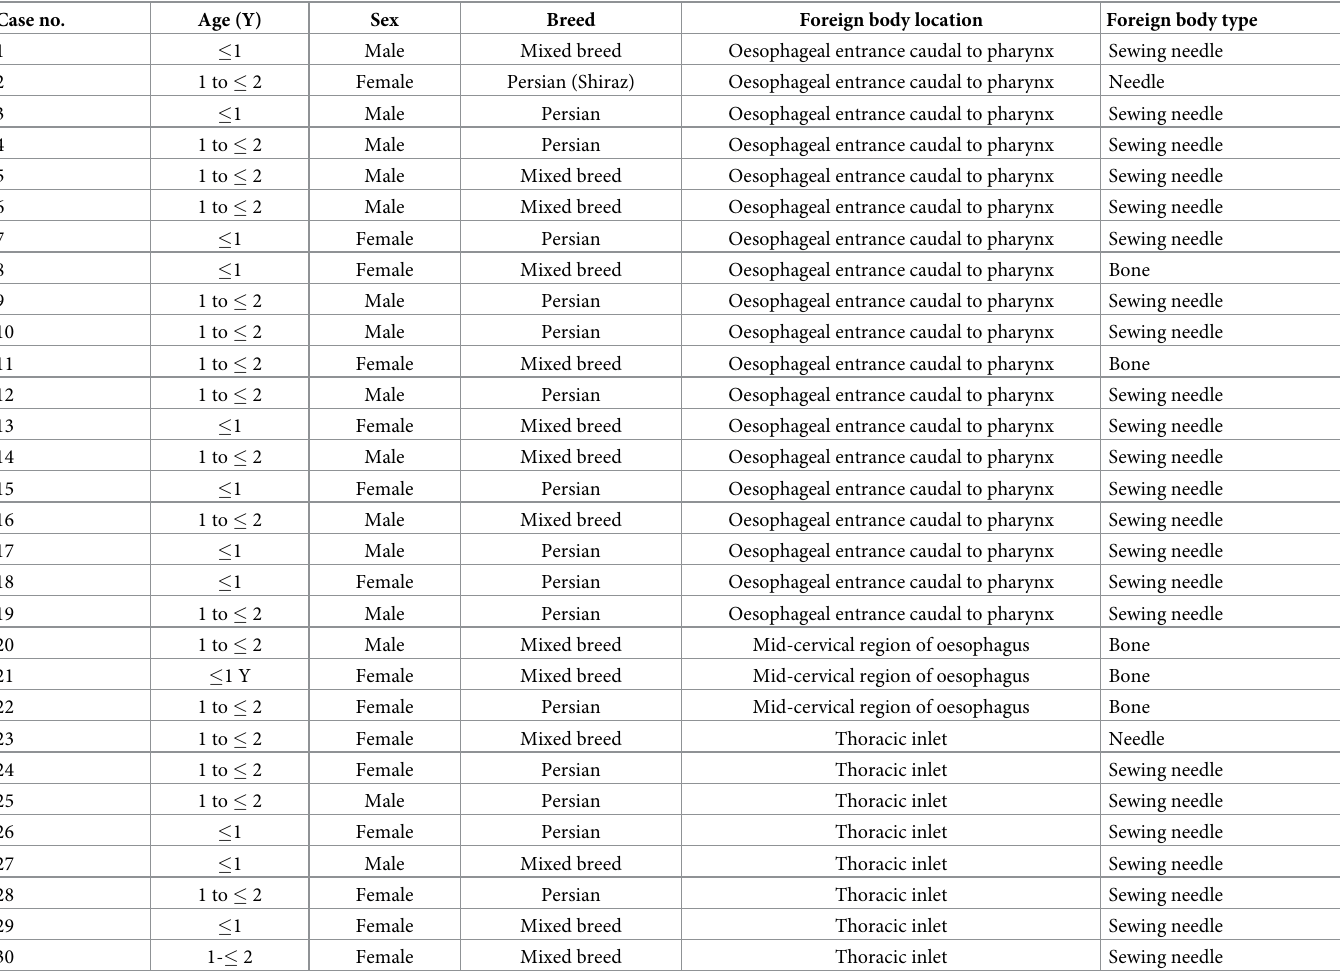
Table 1. Data from thirty cats with oesophageal foreign bodies. Case